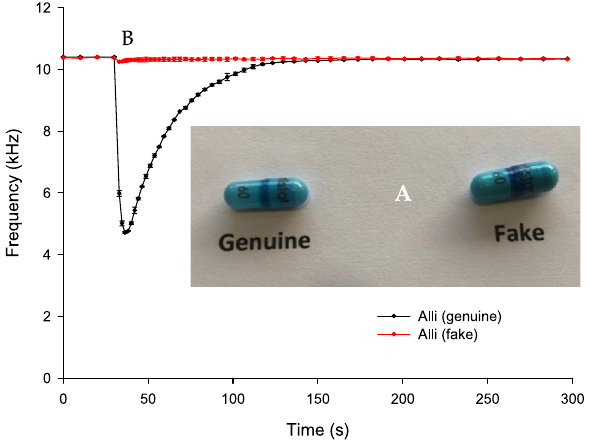
Figure 2. ( A ) an image of genuine and falsified Alli (orlistat) capsules. ( B ) BARDS data of 120 mg of genuine and falsified orlistat powder content dissolved in 25 ml of H 2